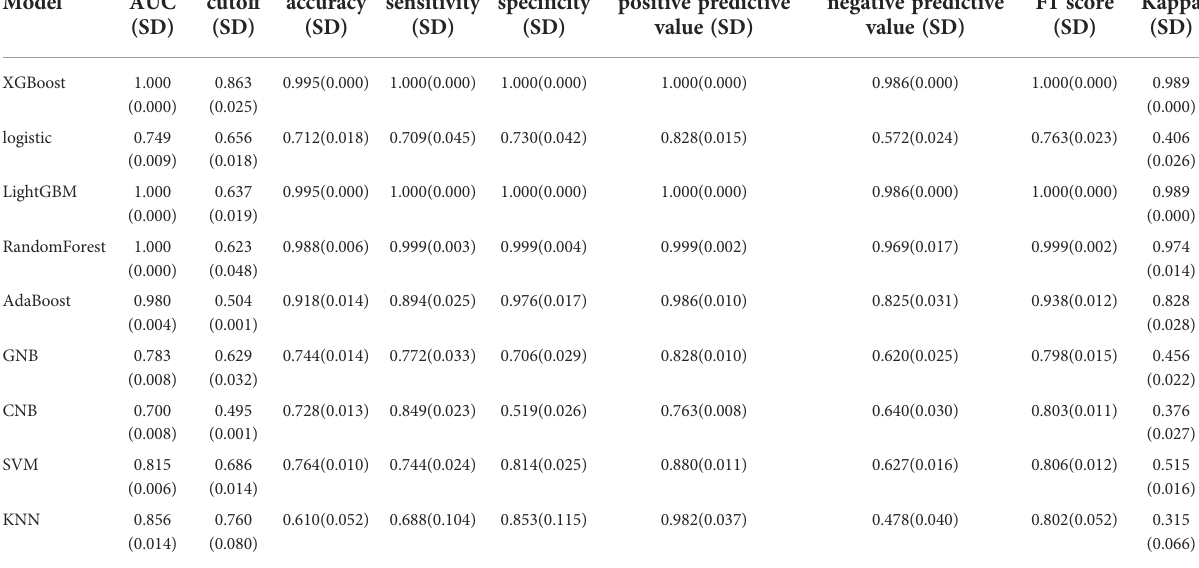
TABLE 1 Multi-model comparison, training set